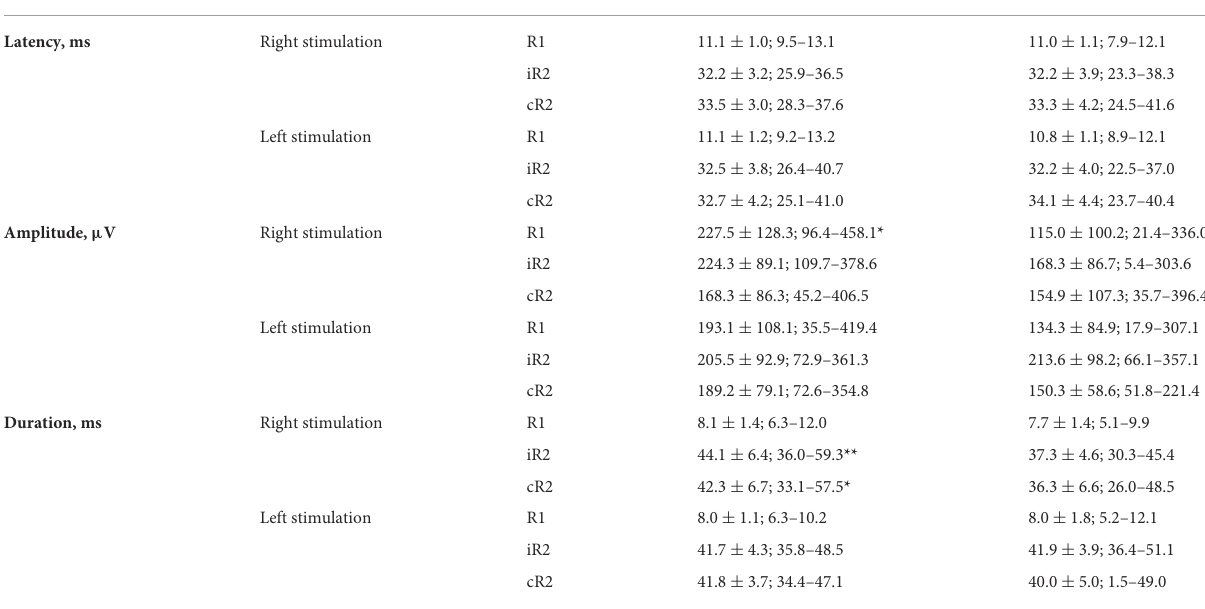
TABLE 3 Findings from the blink reflex in COVID-19 patients and healthy subjects.